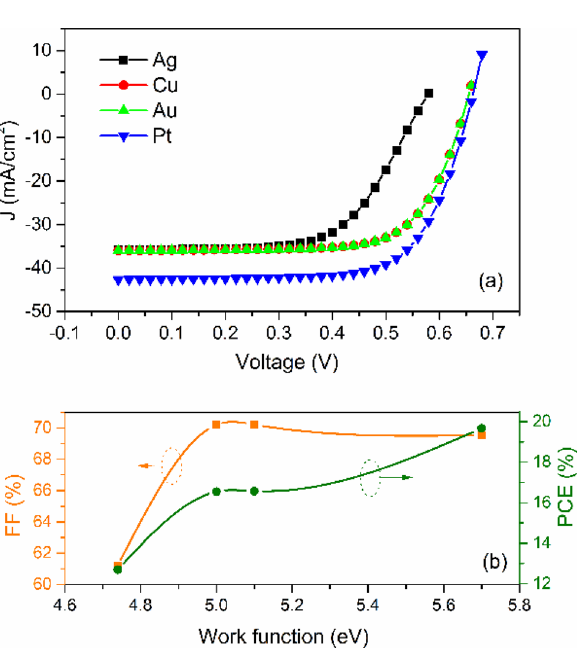
Figure 8. ( a ) J-V characteristics with varied work function ( b ) FF and PCE as a function of work function of anode